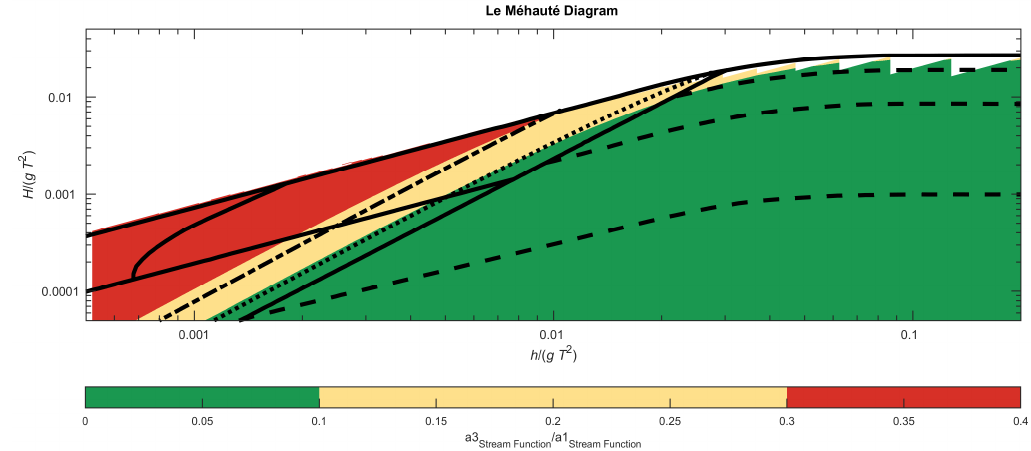
Figure 3. Comparison between the third order and first-order amplitude calculated with stream function wave theory. S = 1.5 for the dotted line and S = 3 for the dashed-dotted line.